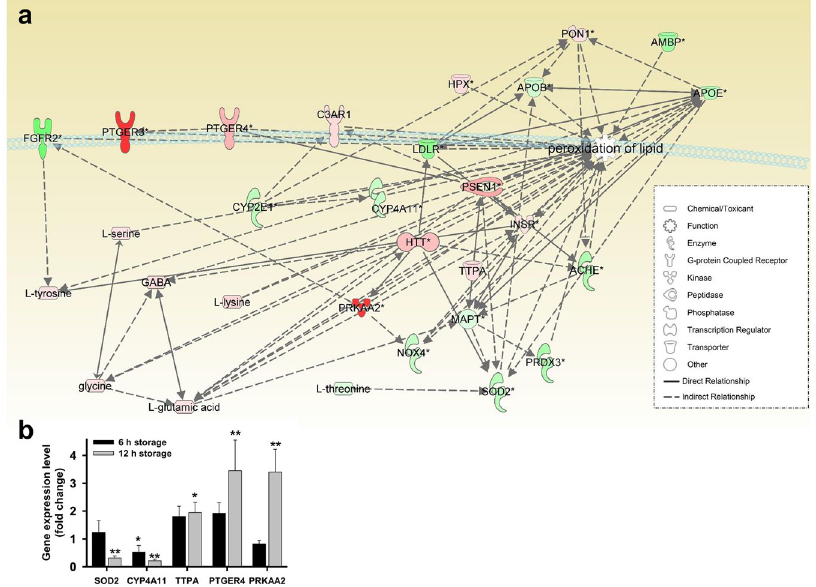
Figure 4. Bioinformatics analysis of microarray and amino acid profiles in hBM-MSCs stored in PBS for 12 h. ( a ) Lipid peroxidation-related genes and amino acid network were constructed algorithmically by IPA. Red and green areas indicate up- and downregulated genes, respectively. Differentially expressed genes obtained from microarray data (genes with > 3-fold change) are shown. ( b ) qPCR analysis of lipid peroxidation-related gene expression in hBM-MSCs stored in PBS for 6 and 12 h. Data represent mean ± SD of three